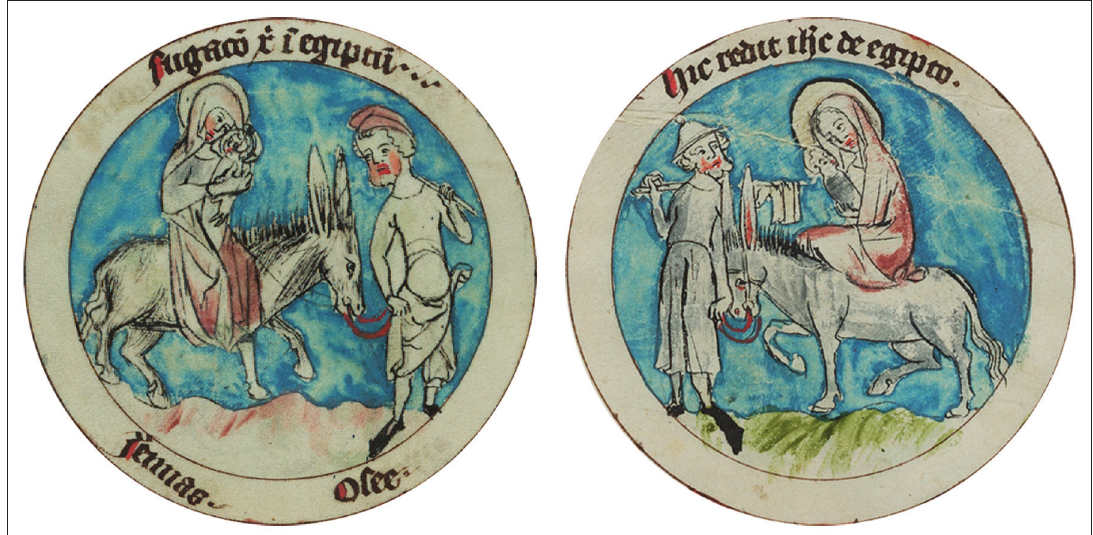
Figure 2: The Flight into Egypt ( left ) and The Return from Egypt ( right ) from a Biblia Pauperum (Sign.: Fol. max 4, fol. 2 v , 3 r ), ca. 1340. © Stiftung Weimarer Klassik, Herzogin Anna Amalia